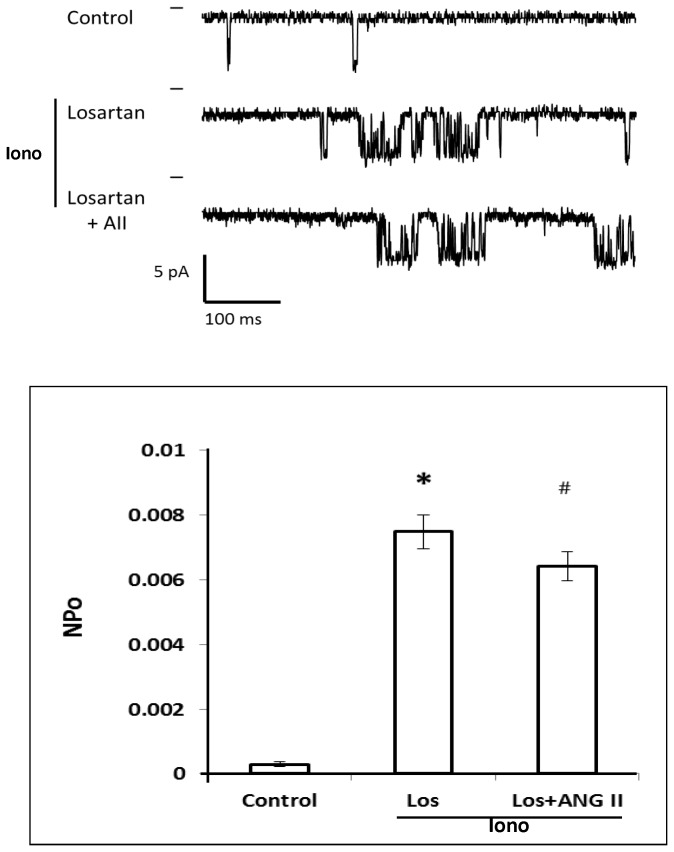
Effect of Losartan on the inhibitory action of ANG II on KCa channel activity in renal VSM cells.The upper panel presents a representative current traces recording of the effects of Losartan and ANG II on the KCa channel activity recorded in the presence of ionomycin. KCa channel currents were recorded with 140 mM KCl in the pipette at the resting membrane potential (pipette potential = 0 mV) and the cells were bathed in normal physiological salt solution in the presence of ionomycin. The lower panel summarizes the effects of Losartan and ANG II on KCa channel activity recorded in the cell attached mode in the presence of ionomycin in the bath. * indicates a significant difference from the control value recorded from the same cells. # indicates a significant difference from the corresponding value recorded in the presence of ionomycin.